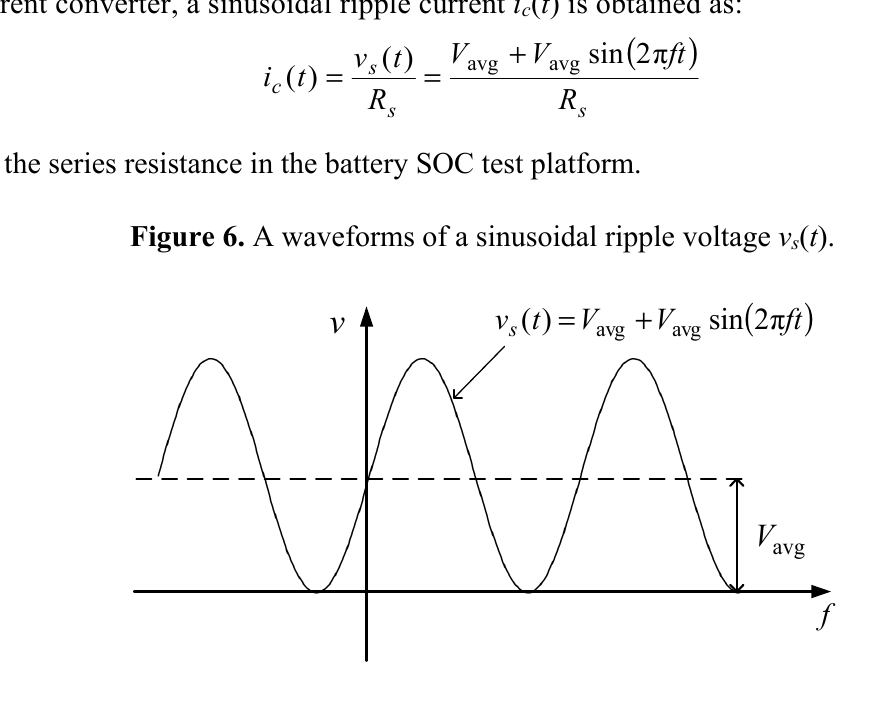
Figure 6. A waveforms of a sinusoidal ripple voltage v